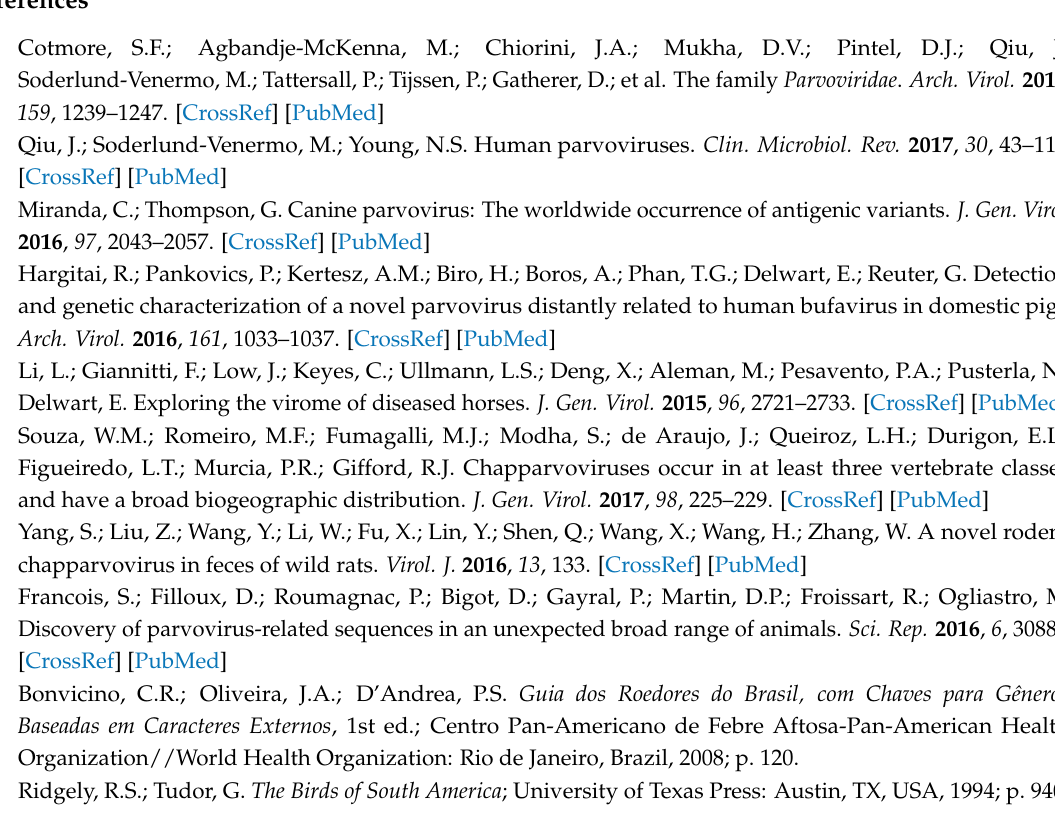
Table S1: Samples information, host, sources, sample type, location, date, reads and %Bases ≥ Q30. Figure S1: Heatmap of pairwise amino acid identities of the NS protein of parvoviruses identified in this study and representative members of the Parvovirinae subfamily based on ICTV criteria. The viruses described in this study are highlighted in bold. Figure S2: Heatmap of pairwise amino acid identities of the VP protein of parvoviruses identified in this study and representative members of the Parvovirinae subfamily based on ICTV criteria. The viruses described in this study are highlighted in bold. Figure S3: Alignment of helicase enzymatic motif showing walker’s